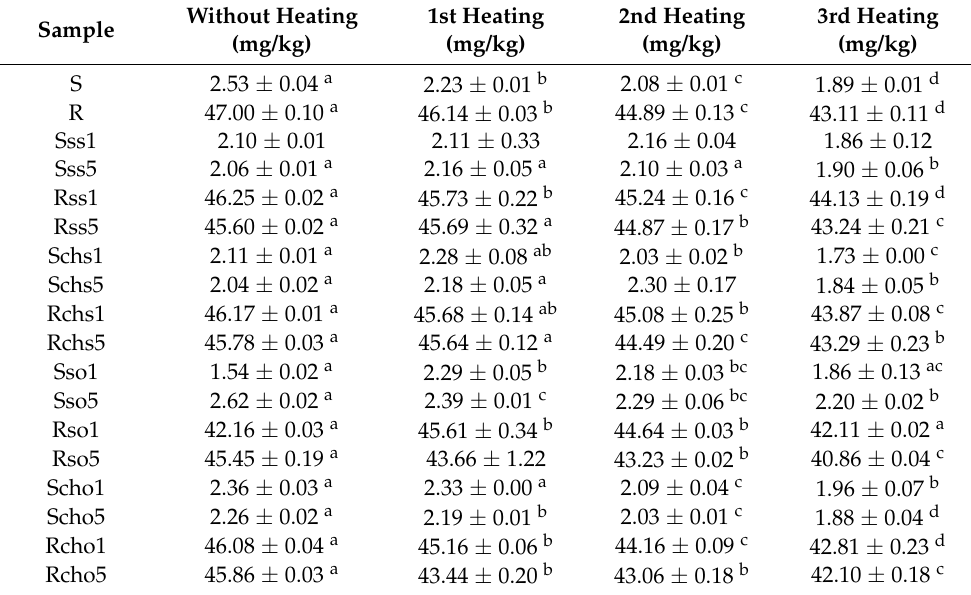
Table 7. Chlorophyll content in fortified oil samples after repeated cycles of heating.